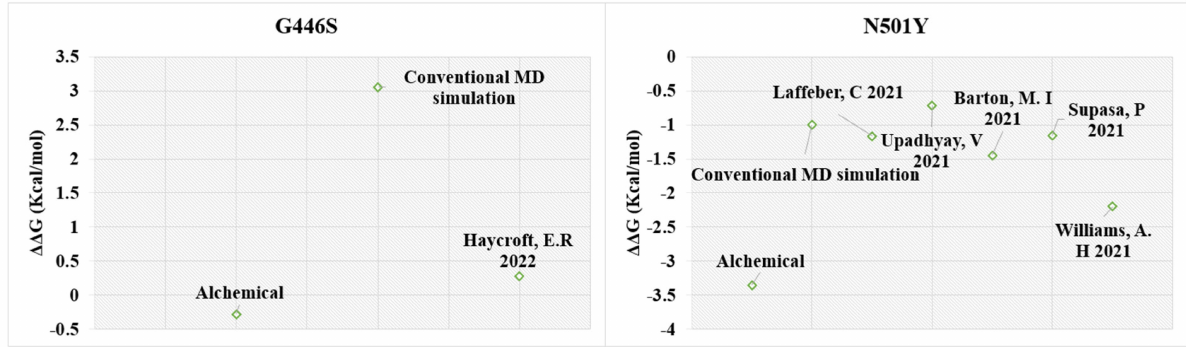
Figure 7. Predicted versus experimentally reported binding affinity of spike receptor-binding domain with hACE2 for the G446S and N501Y mutations . The experimental values were taken from Table 1 and converted to ∆ G [40,66,74,77,78]. The ∆∆ G was calculated by subtracting the binding free energy of the WT spike ( ∆ G WT ) from that of the mutant spike ( ∆ G MUT ). The Prime/MMGBSA method was combined with the conventional MD and carried out for the first 1–25 ns of the simulation trajectory. The alchemical free energy method was carried out with the PMX software using a non-equilibrium